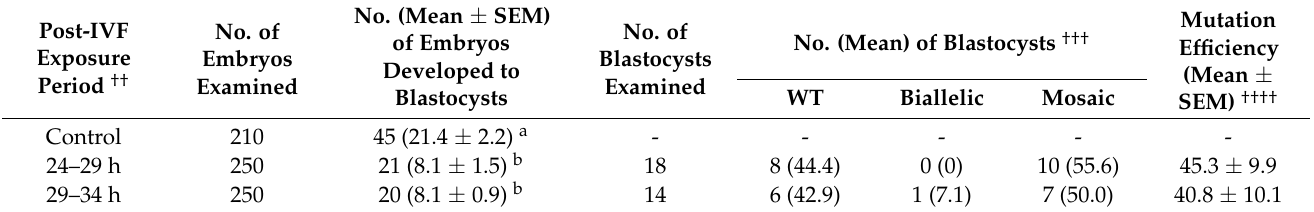
Table 2. Development of zona pellucida (ZP)-free embryos subjected to lipofection-mediated gene editing with gRNA targeting PDX1 after IVF † .